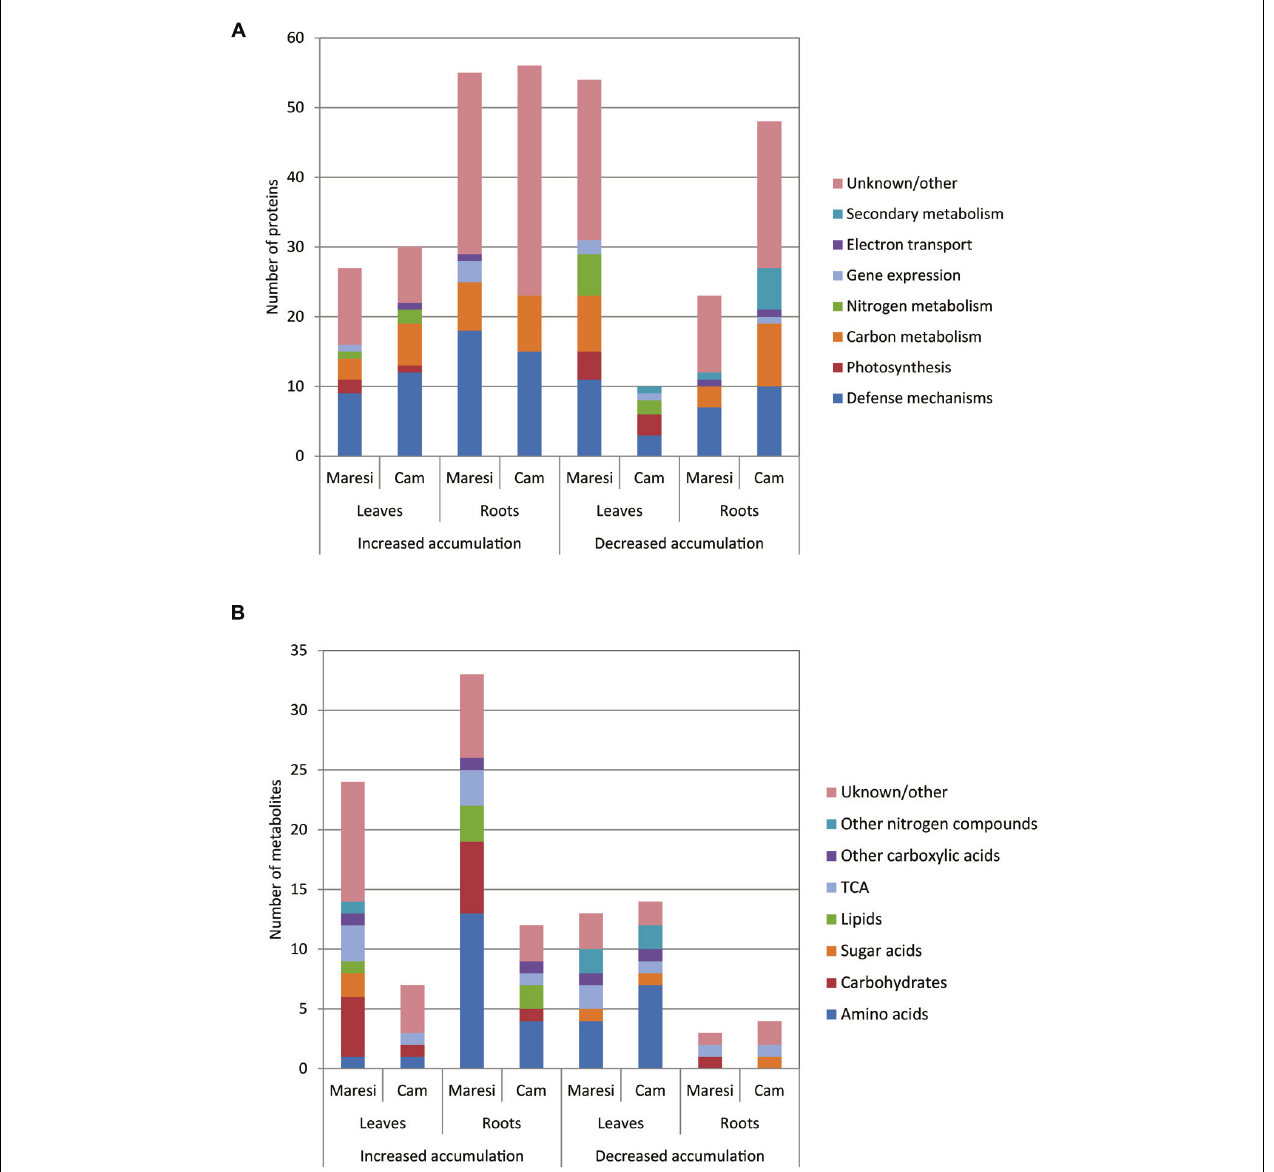
FIGURE 3 | Functional classification of drought-responsive proteins (A) and metabolites (B) identified in leaves and roots of Maresi and Cam/B1/CI